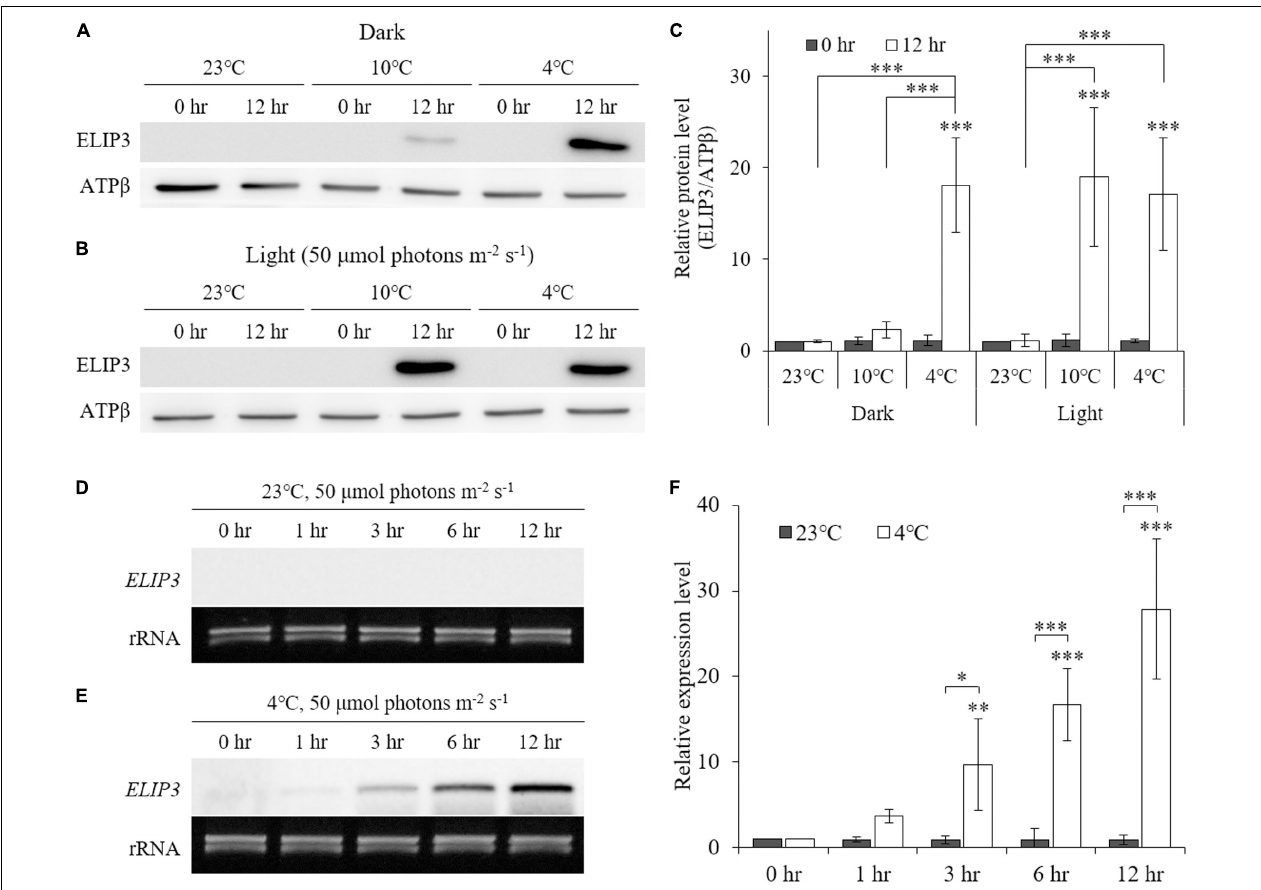
FIGURE 1 | Western blot (A, B) and Northern blot (D, E) analysis showing accumulation of ELIP3 in different temperature regimes (23, 10, and 4 ◦ C). (A) Accumulation in the dark. (B) Enhanced accumulation in light (50 µ mol photons m − 2 s − 1 ). (C) Densitometry of western blot results. Data are expressed as mean ± SD (two-way ANOVA with Bonferroni’s multiple comparisons test, n = 4). (D) Expression of ELIP3 at 23 ◦ C. (E) Expression of ELIP3 at 4 ◦ C. (F) Densitometry of northern blot results. Data are expressed as mean ± SD (two-way ANOVA with Bonferroni’s multiple comparisons test, n = 4). ATP β was used as a loading control for western blotting, and rRNA for northern blotting. ∗ P < 0.05, ∗∗ P < 0.01, ∗∗∗ P < 0.001.